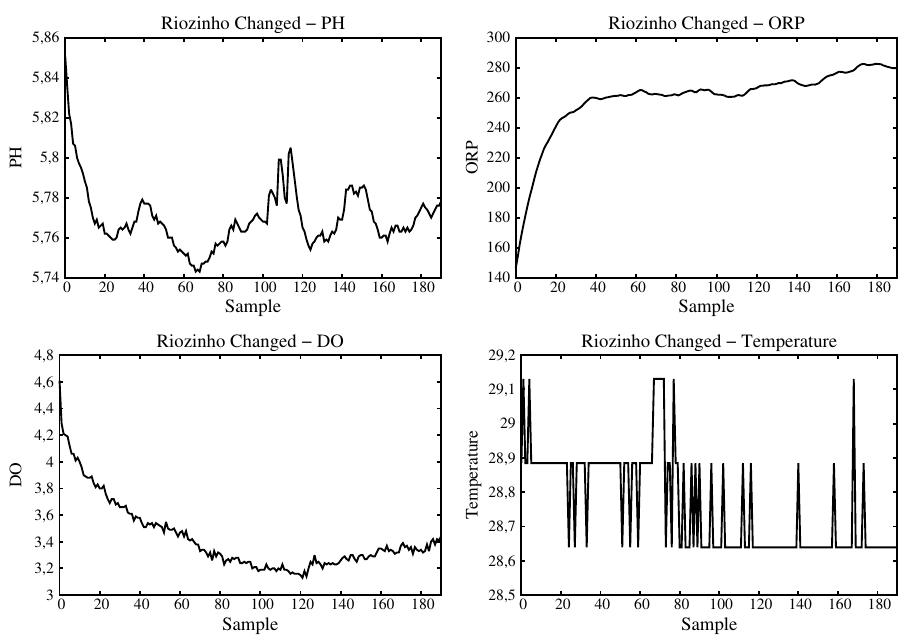
Figure 15. Data acquired and processed for Small River at a place with anthropic